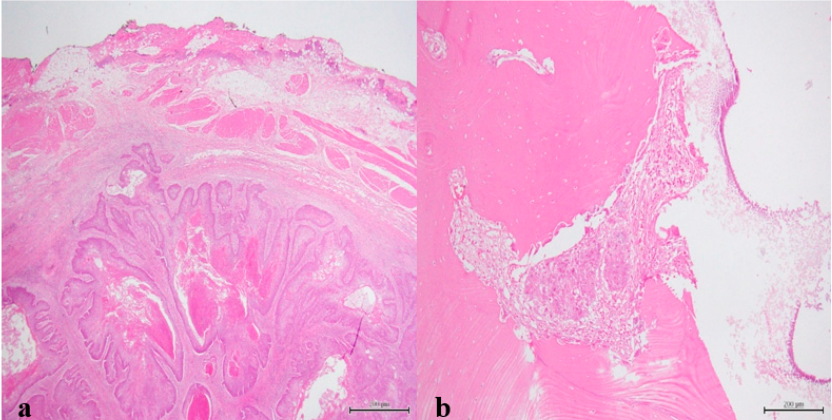
Figure 9. Intraoperative pictures. ( a ) Mandibular defect; ( b ) segmental mandibulectomy and bilateral. Lymph node elective neck dissection, en-bloc excision; (c) harvested fibular flap, donor site.